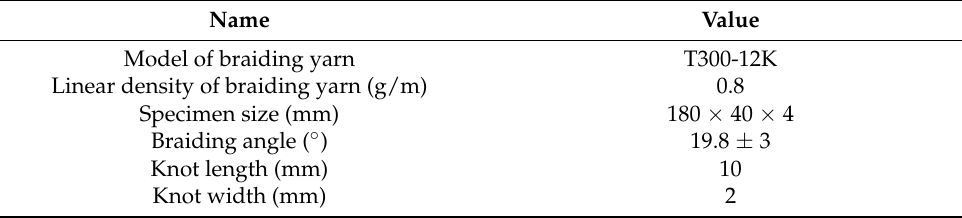
Table 2. Model of specimen.